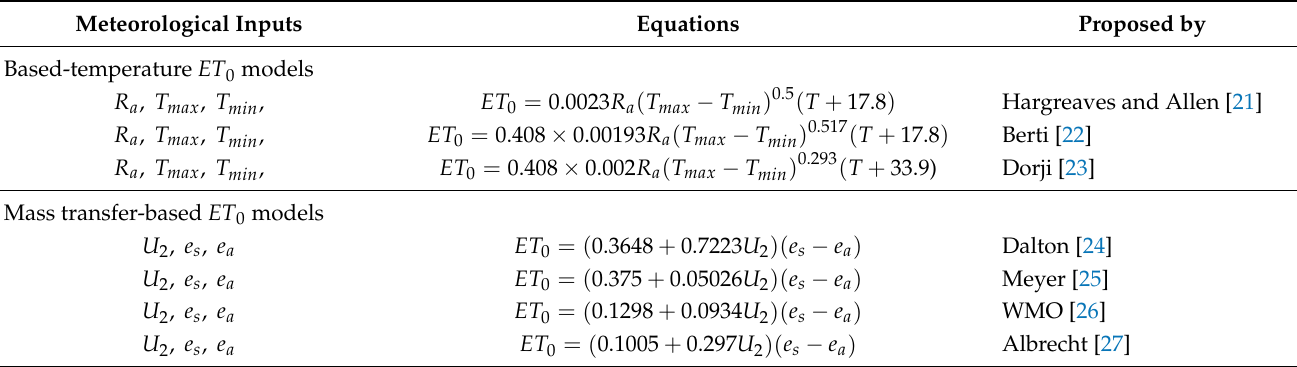
Table 2. Empirical reference evapotranspiration model and parameter calculation. Meteorological